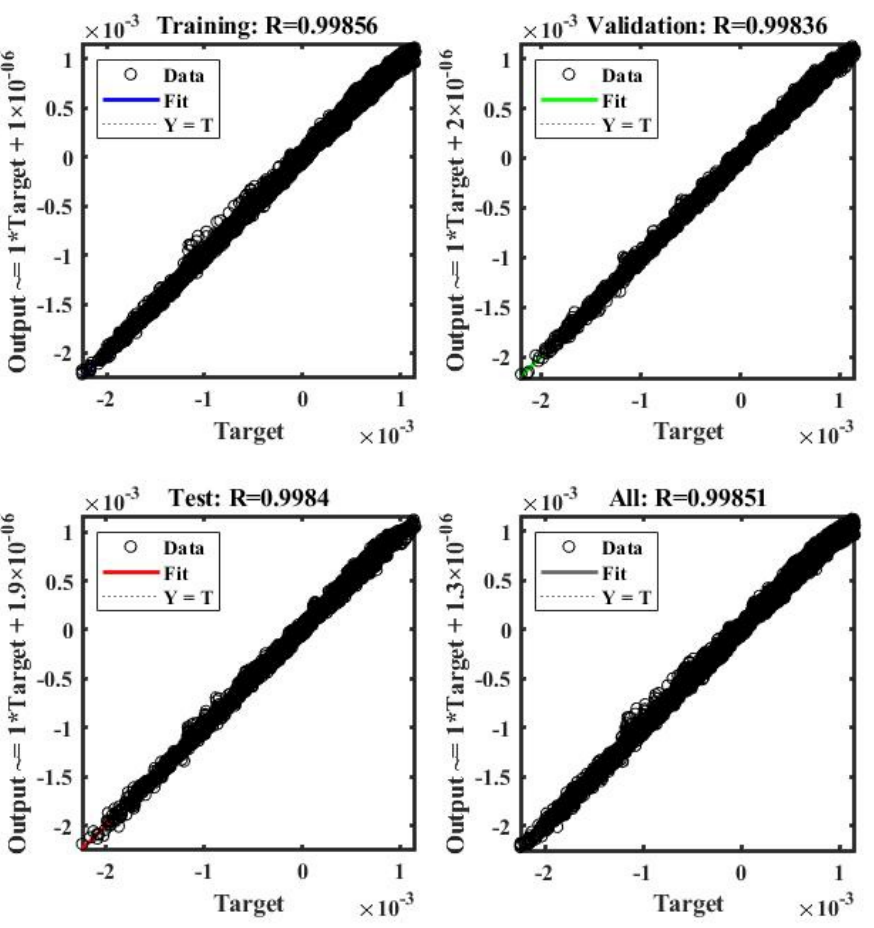
Figure 14. Comparison of the exact and predicted results during training, testing and validation of the DNN